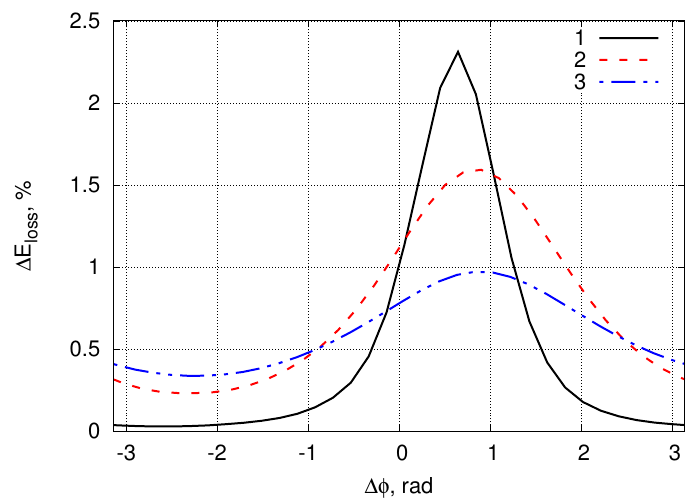
Figure 9. The total energy losses ∆ E loss (in percent—see Formula (39)) of breathers after their collision depending on the relative phase ∆ φ . The picture corresponds to experiment 3 with the relative velocity ∆ V =